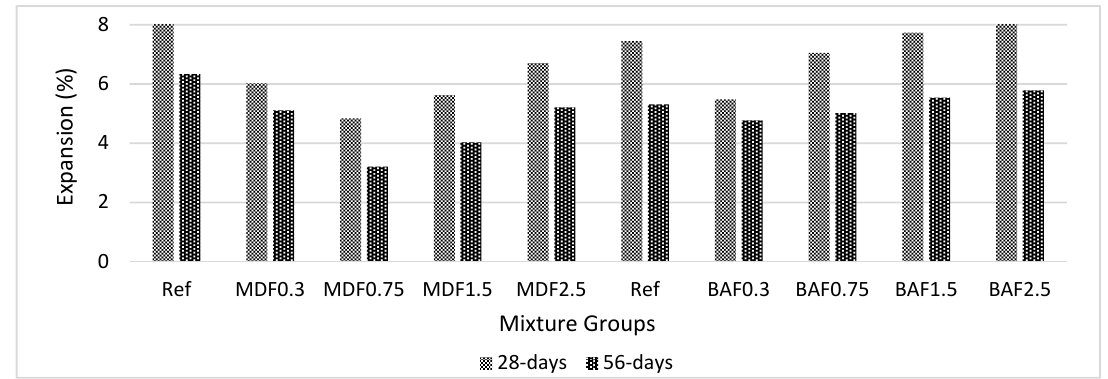
Figure 10. Effect of carbon fiber on sulfate resistance for marble dust and bottom ash mixture groups at 28 and 56 days of curing.